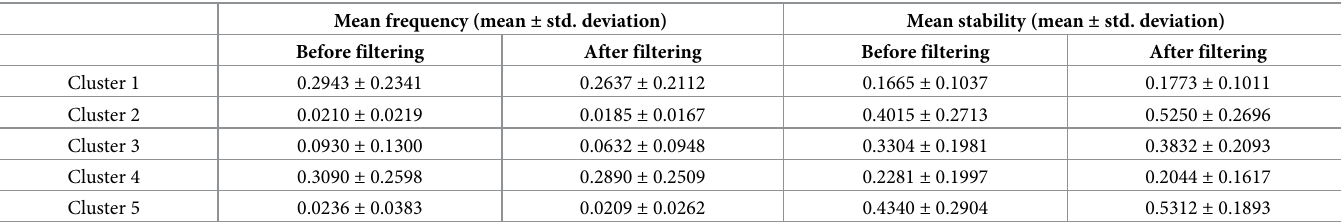
Table 2. Comparison of the mean stability (magnitude of eigenvalue) and mean frequency (argument of eigenvalue) of the clusters before and after filtering. Mean frequency (mean ± std.